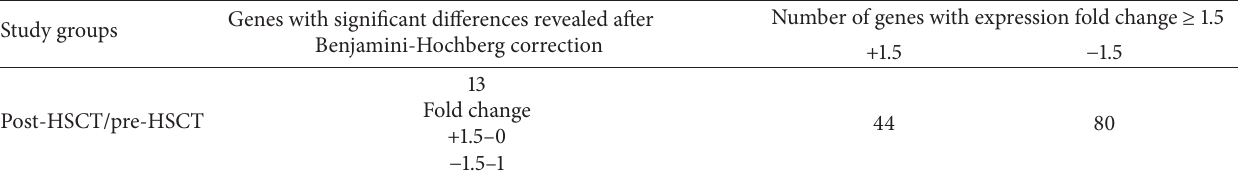
Table 3: Summary of the number of differentially expressed genes between studied groups. Study